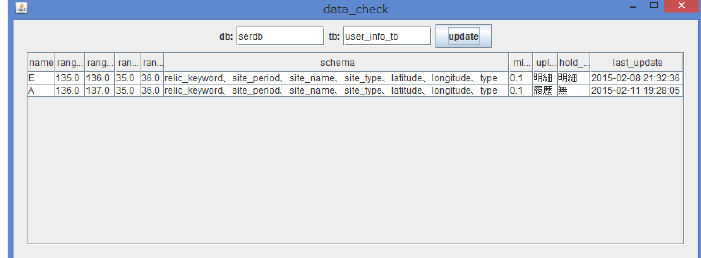
Fig. 9. Window for confirming users’ data.